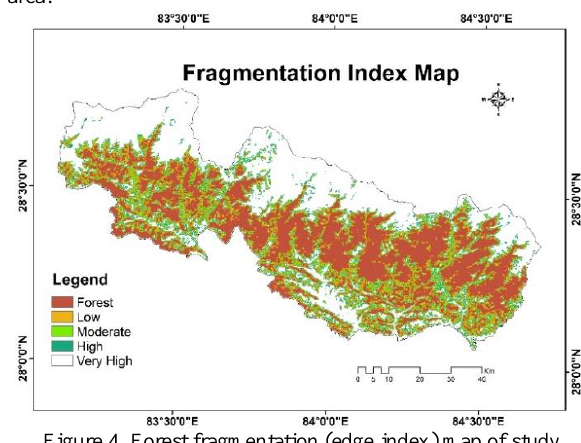
Figure 4. Forest fragmentation (edge index) map of study area